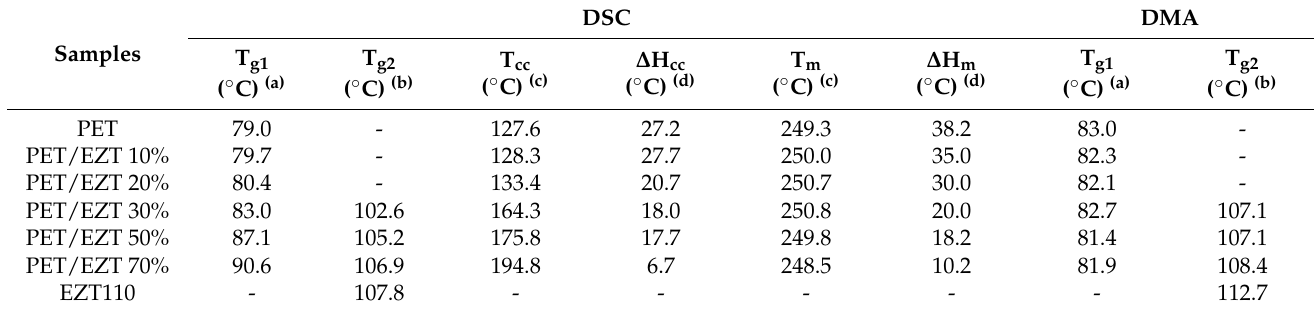
(a) first observed glass transition temperature of the PET/EZT samples. (b) second observed glass transition temperature of the PET/EZT samples. (c) cold-crystalline temperature and melting temperature of the PET/EZT samples, respectively. (d) enthalpy of cold-crystalline and enthalpy of fusion of the PET/EZT samples, respectively.